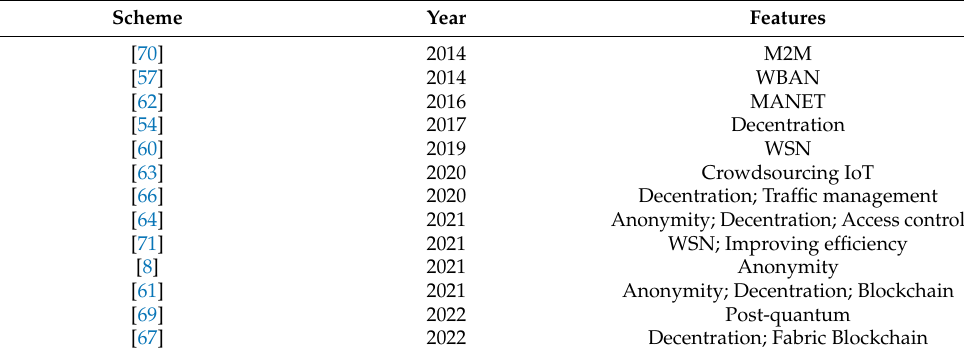
Table 6. ZKP-based Authentication in IoT.